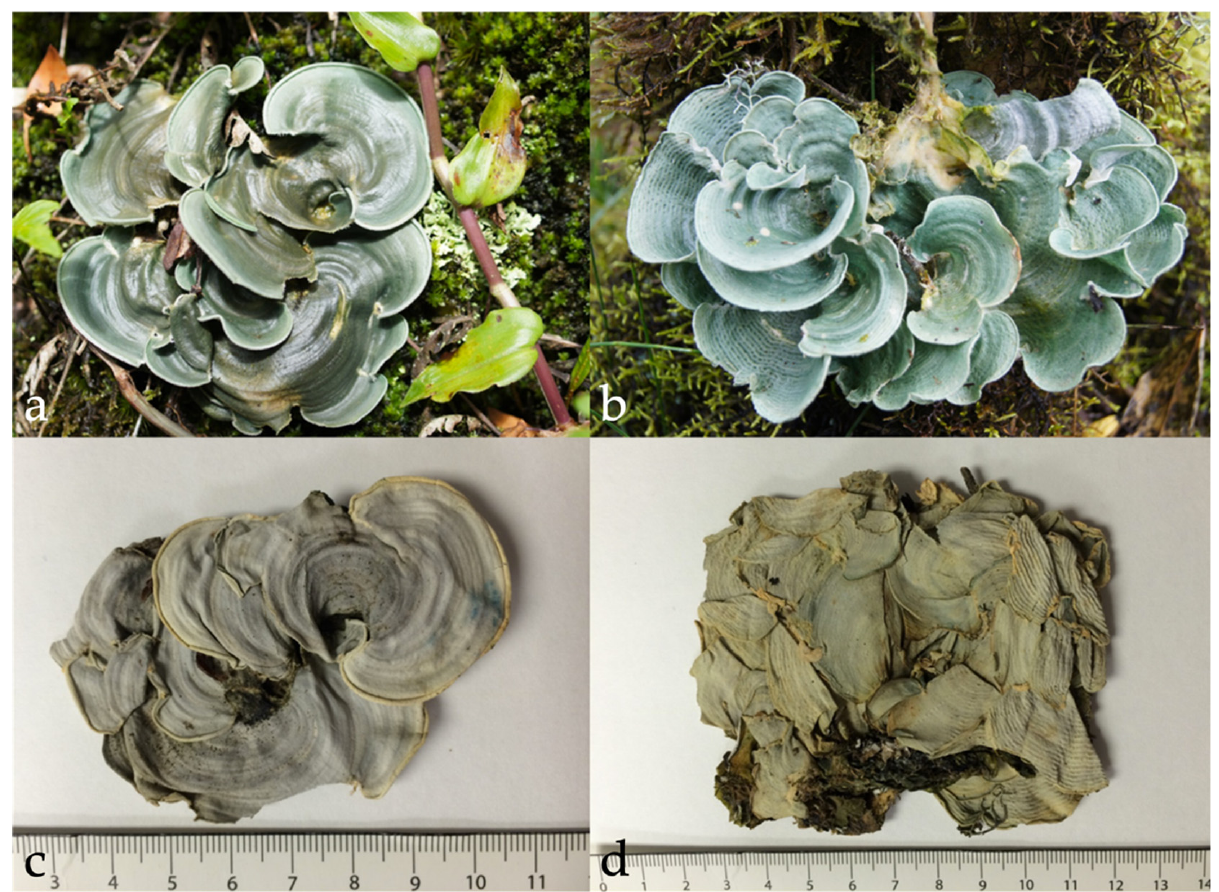
Figure 1. Comparison of fresh samples in their natural habitat ( a , b ) versus dried and deposited in the herbarium ( c, d ) – a, c : Cora spec ‐ 023 (Dal Forno 2042), b, d : Cora cyphellifera (Dal Forno 1808).